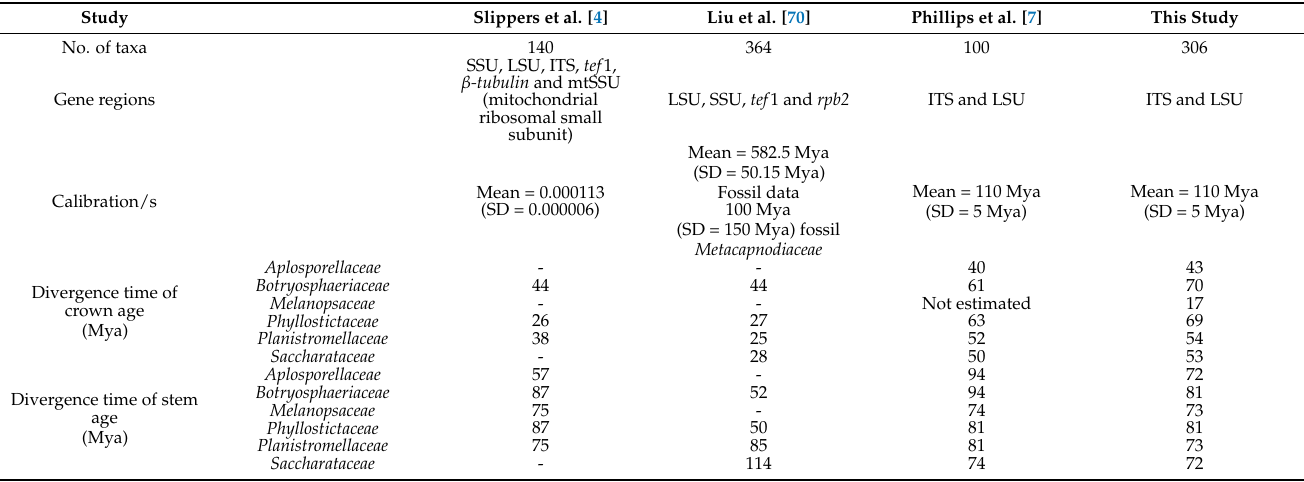
Table 4. Details of the divergence times of crown age and stem age of Botryosphaeriales families in different